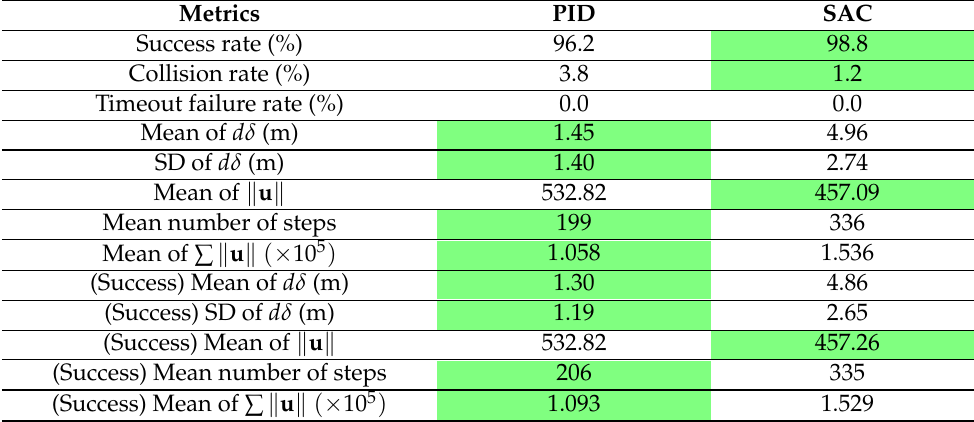
Table 6. Testing phase of a model after removing the position vector, the Euler angles, and the pitch error from the state vector, trained on 2500 episodes. For each metric, the controller with the best score is highlighted in